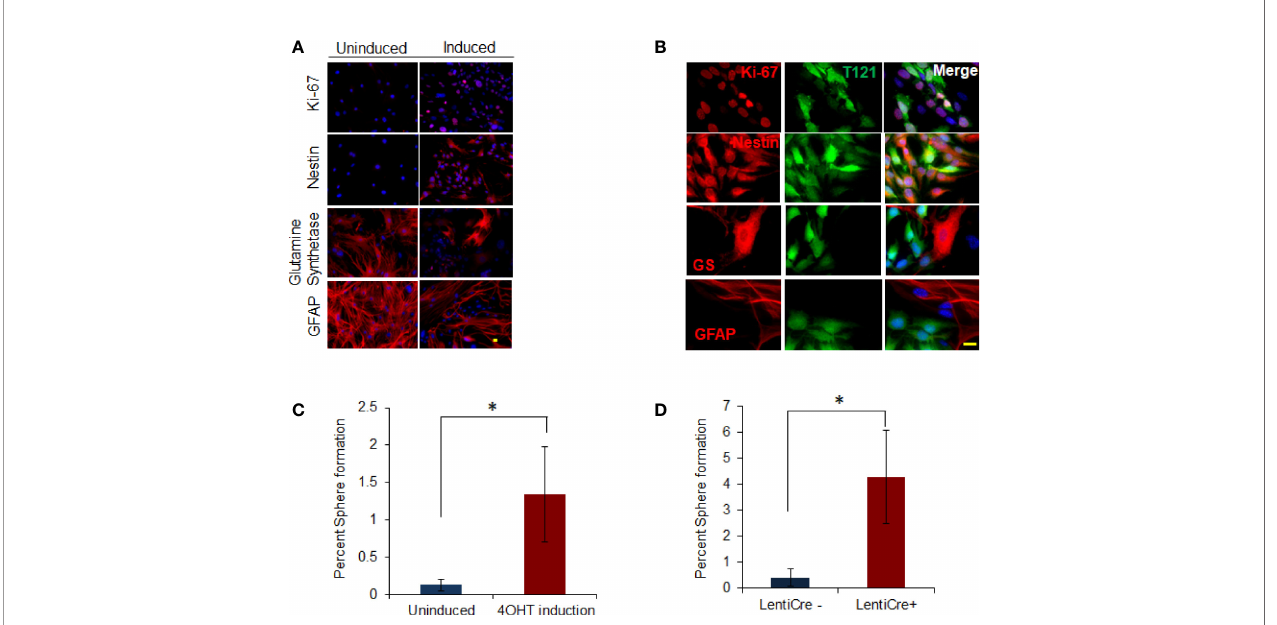
FIGURE 1 | In vitro dedifferentiation of astrocytes. (A) Images showing uninduced and induced astrocytes after 4OHT addition stained with Ki-67 and nestin, glutamine synthetase and GFAP (in Red) using immuno fl uorescence. Nuclei counterstained with DAPI (blue). Scale bar indicates 20 micron. (B) Images showing astrocytes induced with 4OHT and co-stained with T 121 (Green) and Ki-67, nestin, glutamine synthetase (GS) and GFAP (Red) respectively using immuno fl uorescence. Nuclei counterstained with DAPI (blue). Scale bar indicates 20 micron. (C) Histogram showing percent sphere formation from in-vitro progenitor-like transition of T astrocytes. Blue bar indicates percent sphere formation from uninduced astrocytes and red bar shows percent sphere formation upon 4OHT induction. N-5 mice and 4000 astrocytes per sample where analyzed. * indicates p value < 0.05%. (D) Histogram showing percent sphere formation from in-vitro progenitor-like transition of triple knockout Rb lox/lox, p107-/-, p130 lox/lox astrocytes. Cre recombinase is introduced in the cells by lenti virus infection. Blue bar indicates percent sphere formation from uninduced astrocytes and red bar shows percent sphere formation upon lenti-cre induction. N-6 mice and 4000 astrocytes per sample where analyzed. * indicates p value <